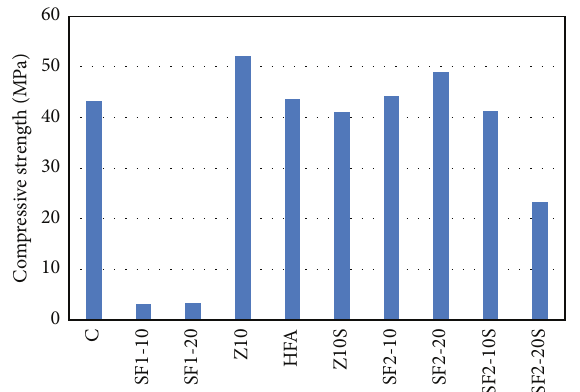
Figure 6: Compressive strength results of fly ash-slag